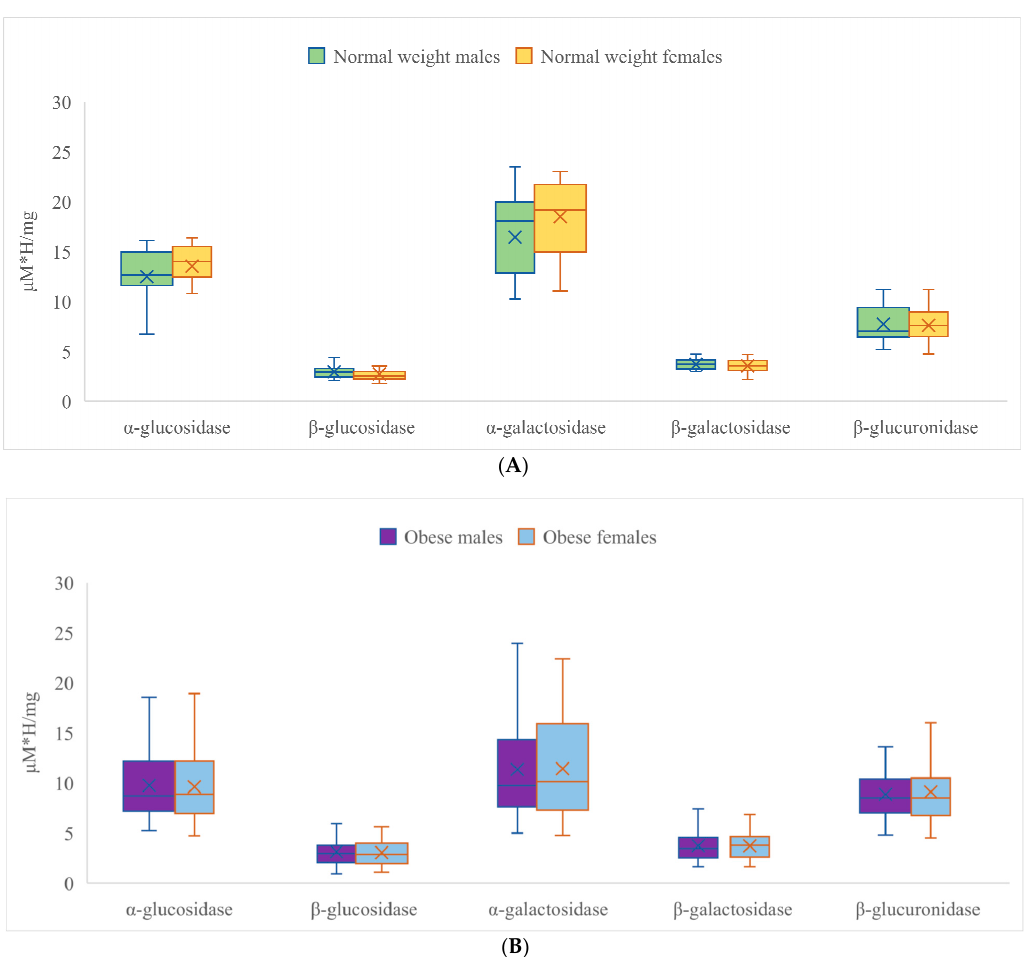
Figure 4. Comparison of the activity of fecal enzymes differentiated between males and females and according to anthropometric status (A) – presents data of normal weight males and females; (B) – presents data of obese males and females. and according to anthropometric status ( A )—presents data of normal weight males and females; ( B )—presents data of obese males and